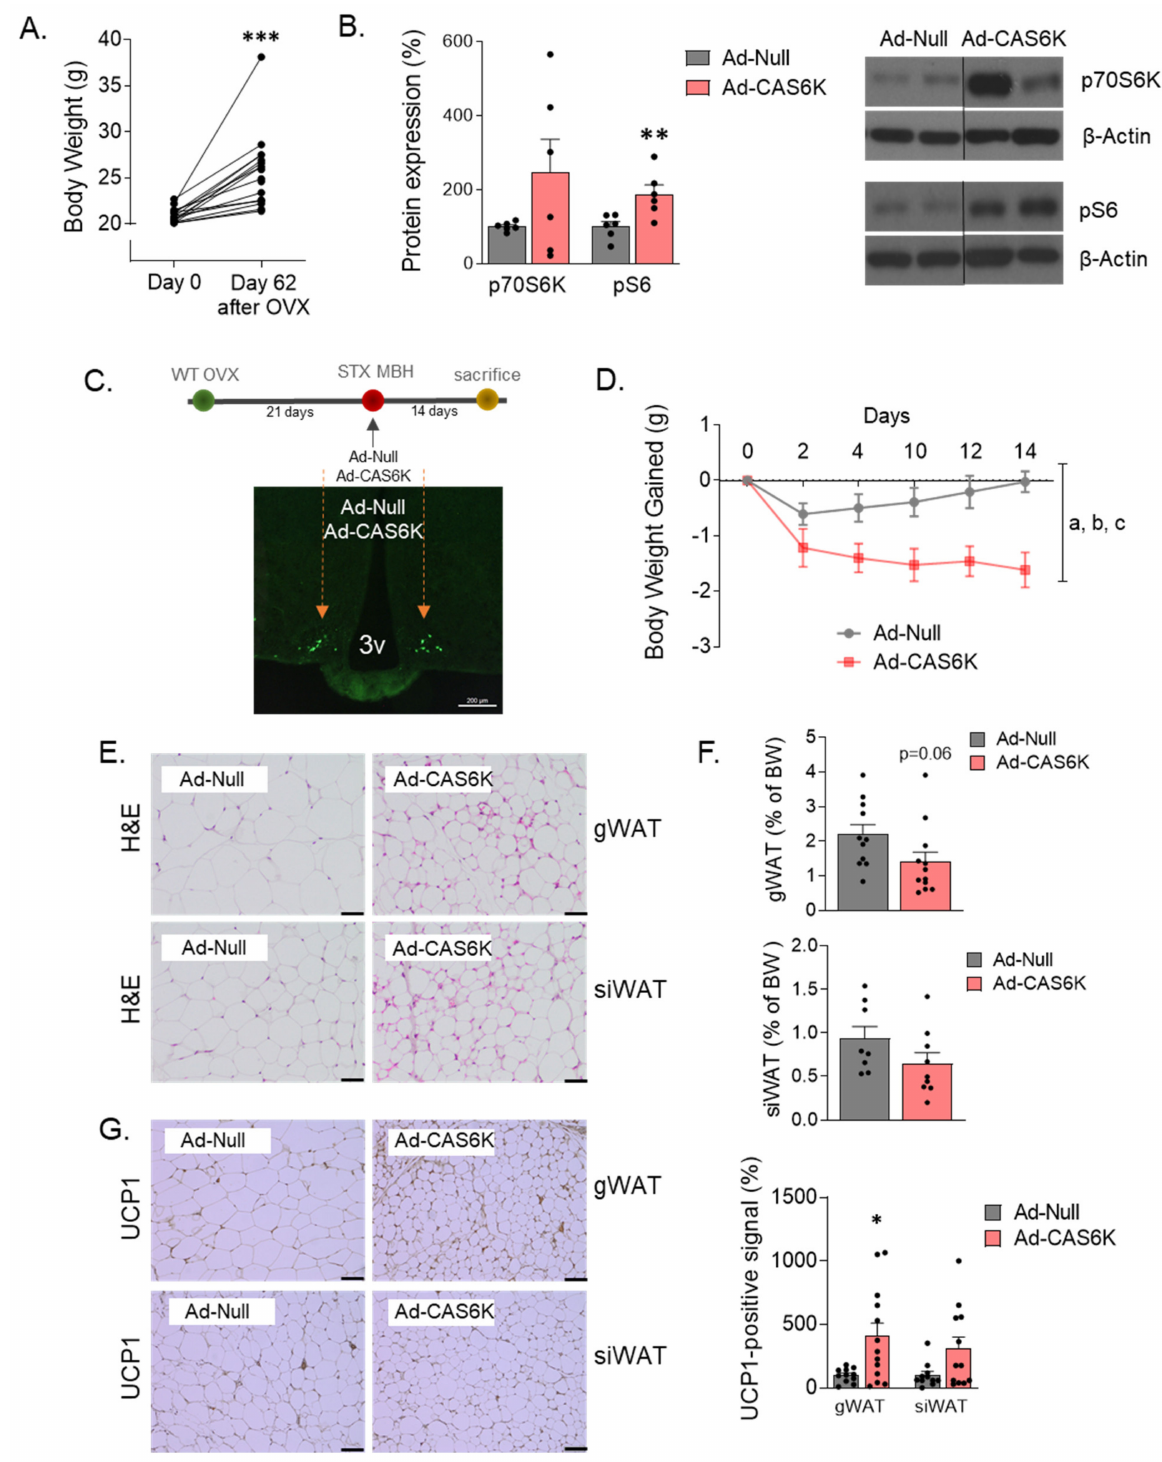
Figure 7. Constitutive activation of p70S6K in medial-basal hypothalamic area (MBH) reduces